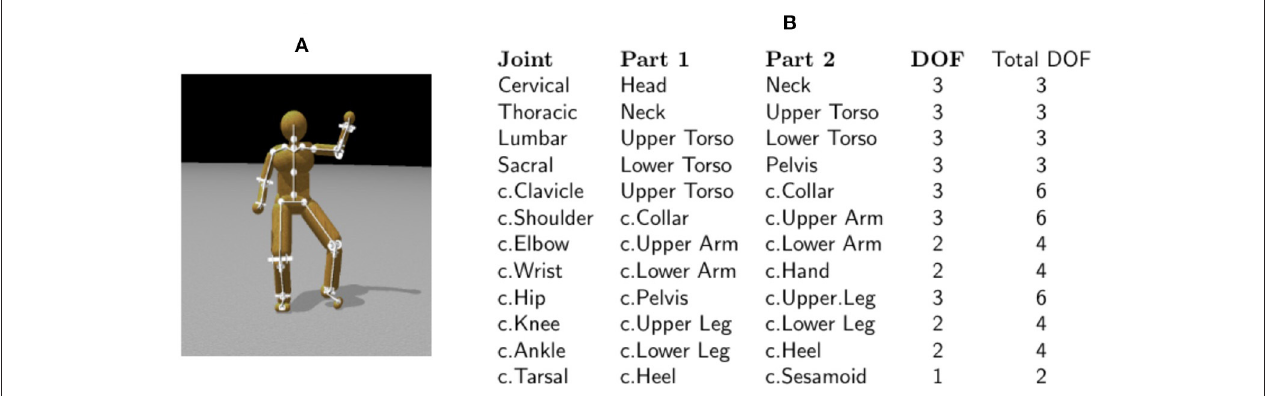
FIGURE 1 | The 48 degree of freedom model. (A) The skeleton of a character model: 21 body segments connected by 20 joints. (B) A summary of the joints used in the model. c., chiral: there are two of each of these joints (left and right). Four ball-and-socket joints connect five body-segments along the spine from the head to the waist. Ball-and-socket joints are also used at the collar-bone, shoulder, and hip. Universal joints are used at the elbows, wrists, knees, and ankles. Hinge joints connect the toes to the heels. All joints limit the range of motion to angles plausible for human movement. Our model assumes that joint DOFs summarize the effects of component muscles.